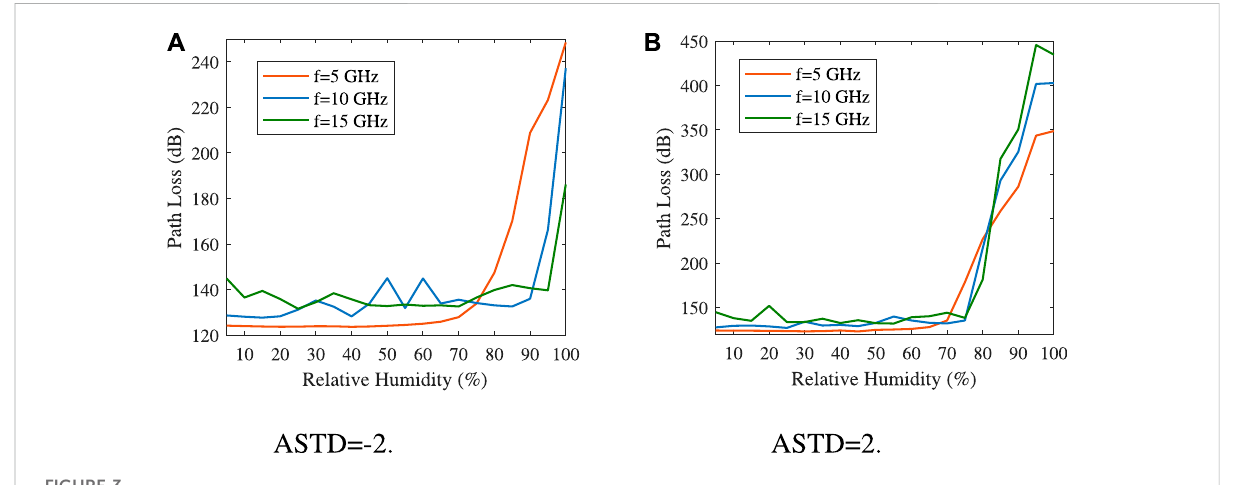
FIGURE 3 Variation in path loss with relative humidity under different ASTD. (A) ASTD = − 2. (B) ASTD =